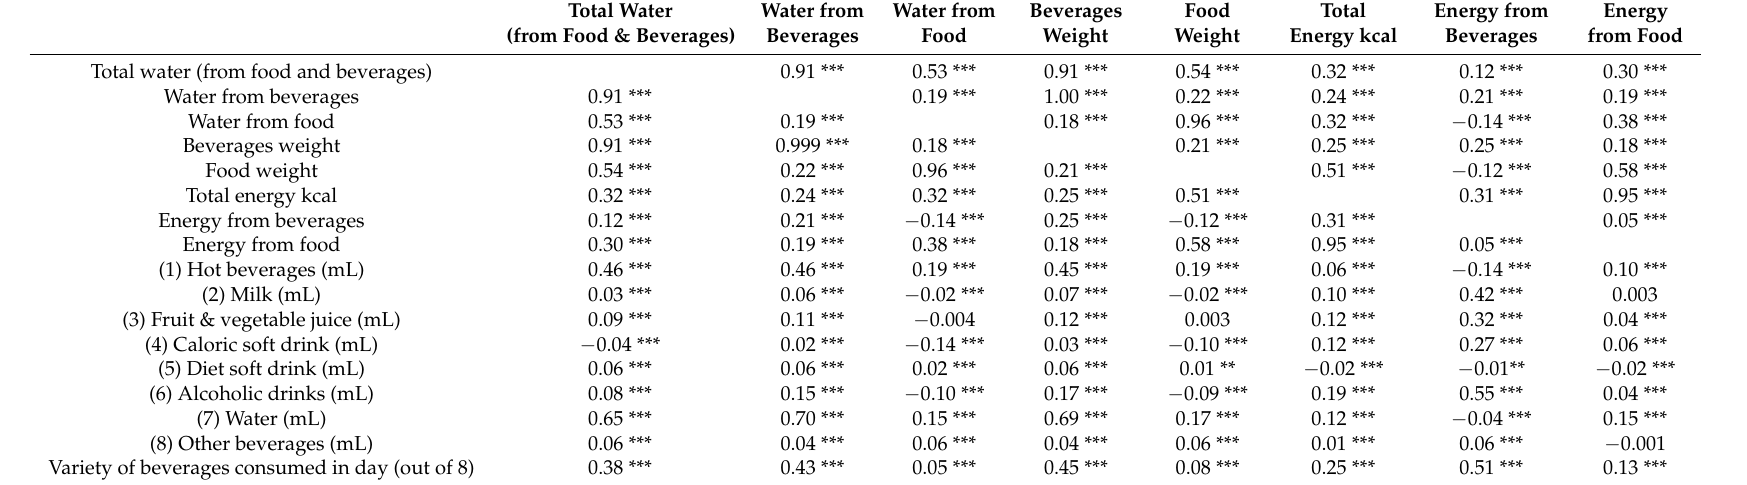
Variety of beverages consumed in day (out of